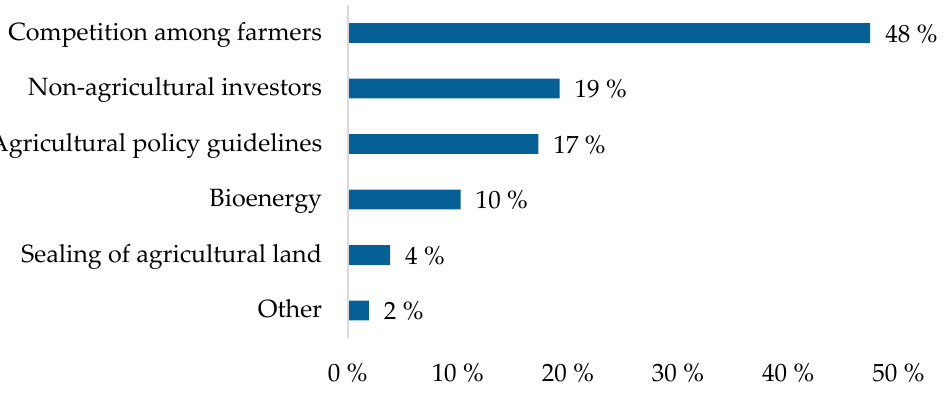
Figure 4. Farmers’ perceptions on the strongest influencing factor on the agricultural land rental market (N = 156). Note: Multiple answers were not possible.